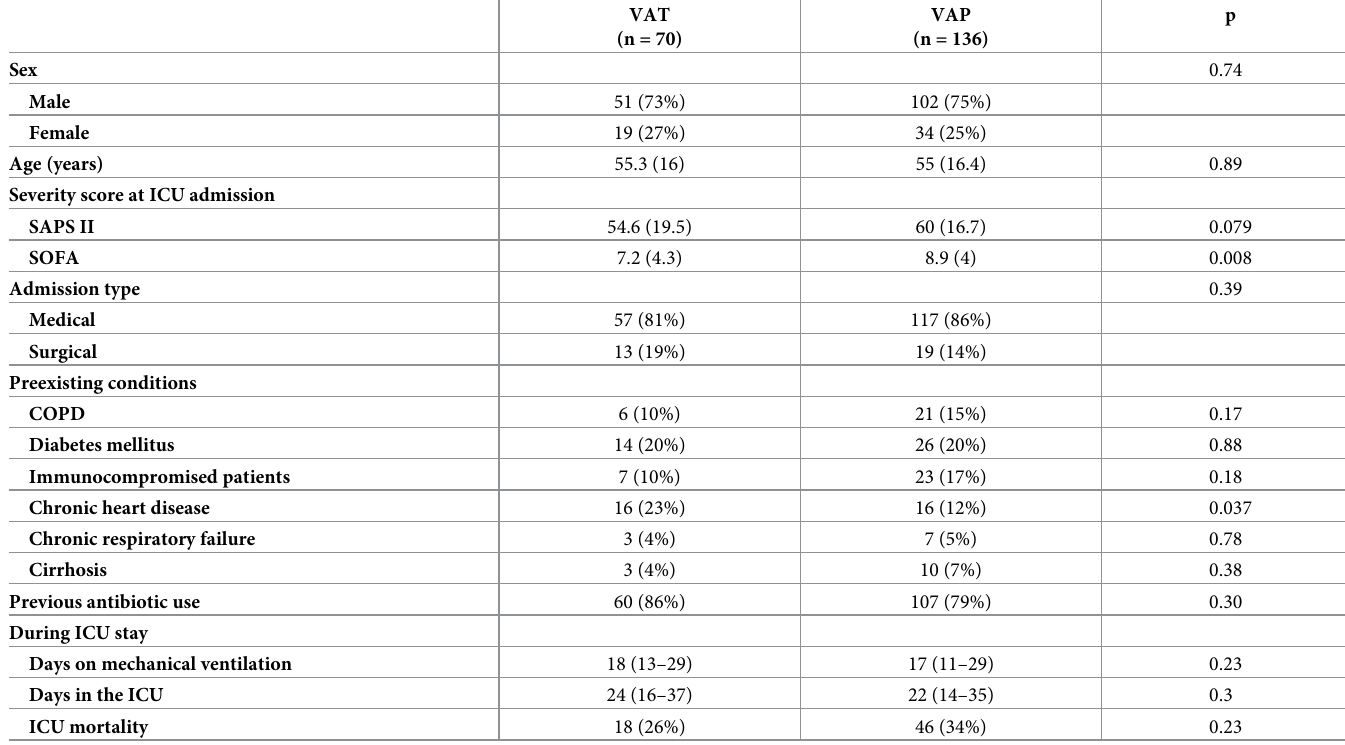
Table 1. Study population